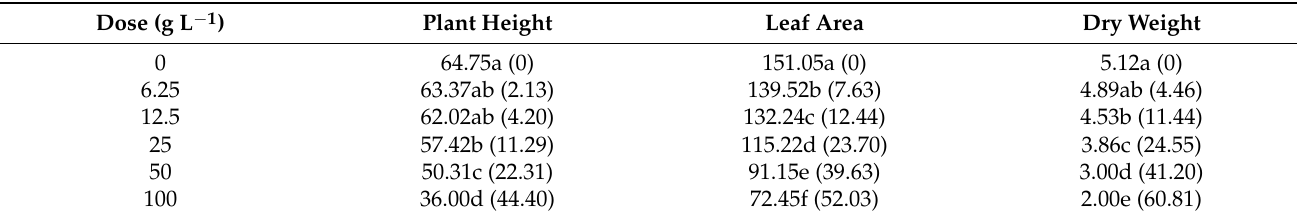
Table 2. Effect of P. hysterophorus methanol extracts on the plant height (cm), leaf area (cm 2 ) and dry weight (g pot − 1 ) of C. iria.